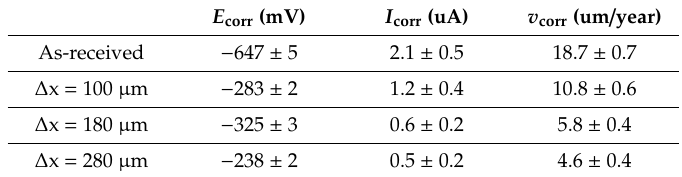
Table 4. Electrochemical parameters determined from the potentiodynamic